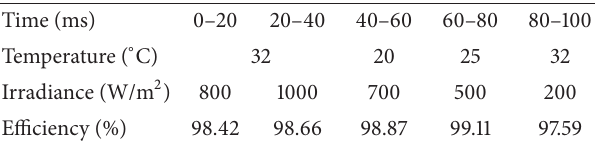
Table 8: Comparison of the global average efficiency for the MPPT